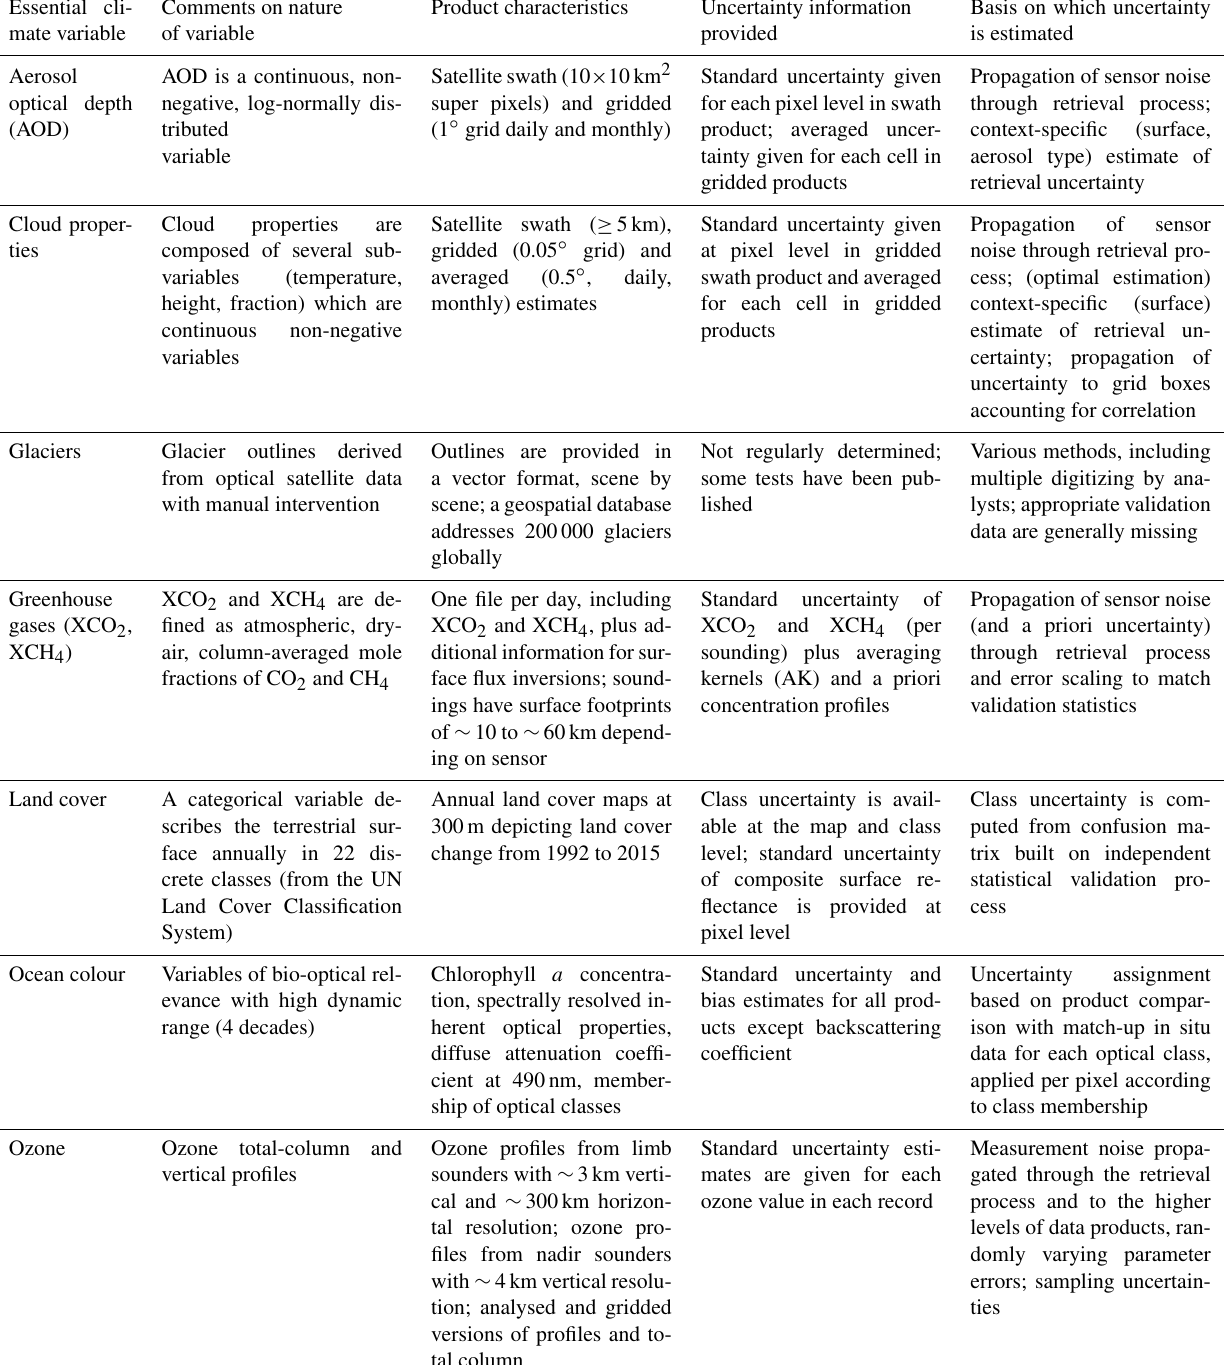
Table 1. Essential climate variables addressed in the ESA Climate Change Initiative. Essential